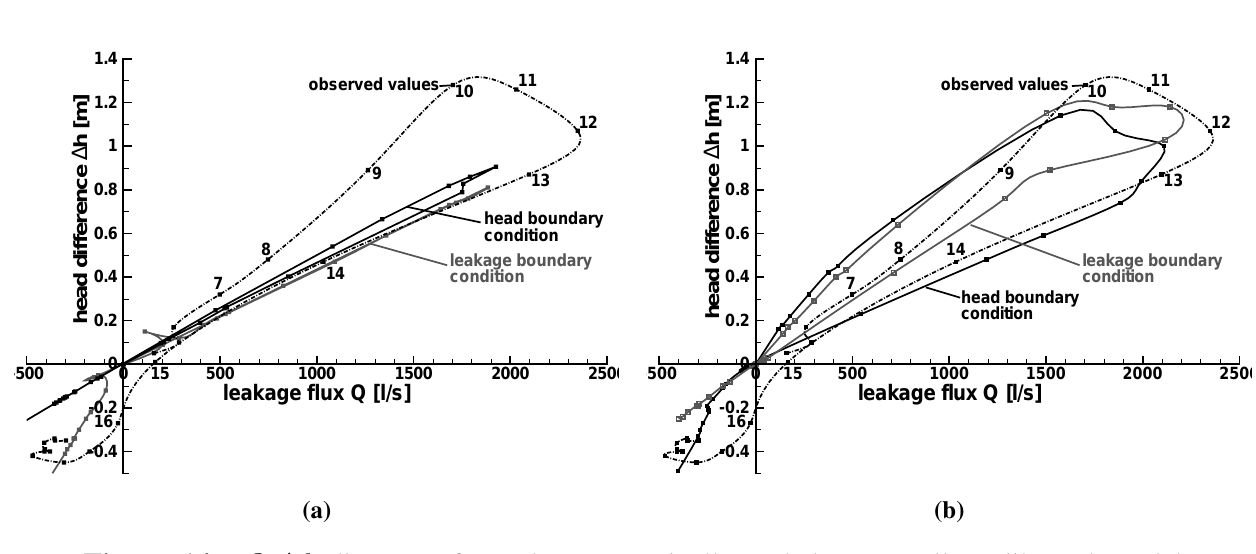
Figure 14. Q - ∆ h -diagrams from the automatically and the manually calibrated